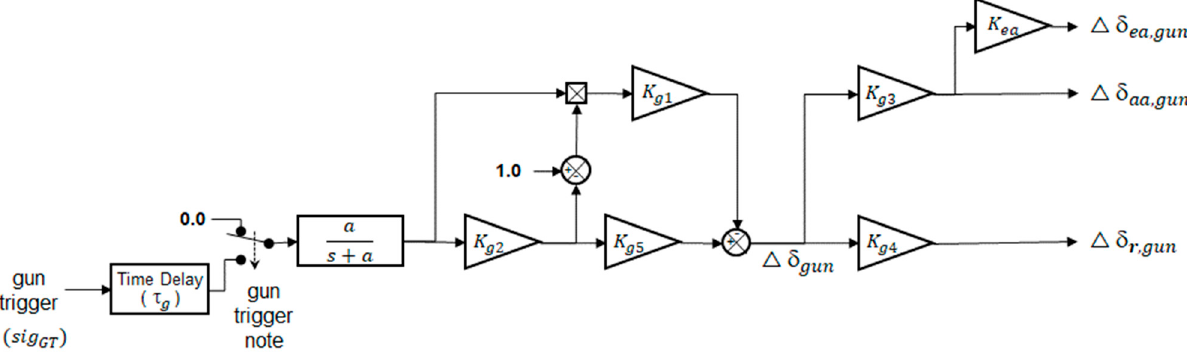
Figure 4. Structure of open-loop gun compensation control.